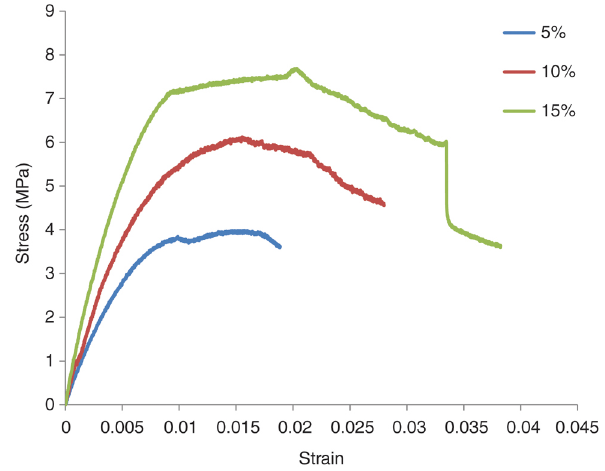
Figure 7: Stress-strain curve for samples prepared at 70°C temperature and 70 bar